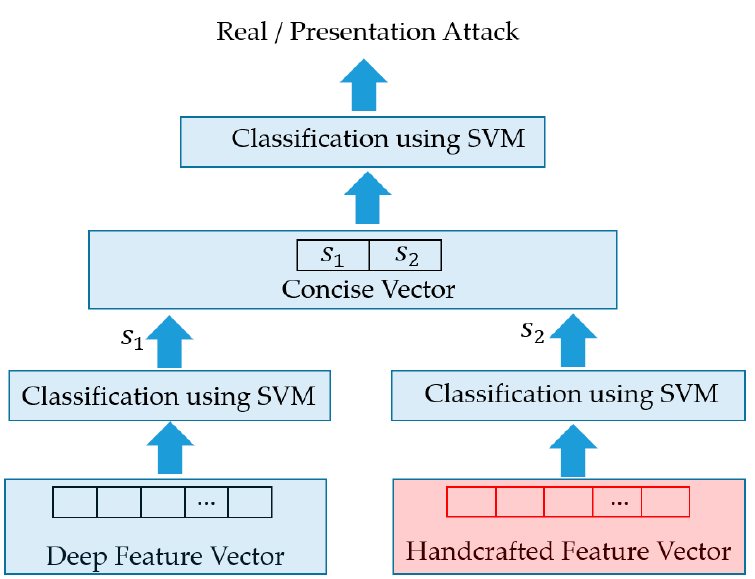
Figure 6. Feature level fusion approach.